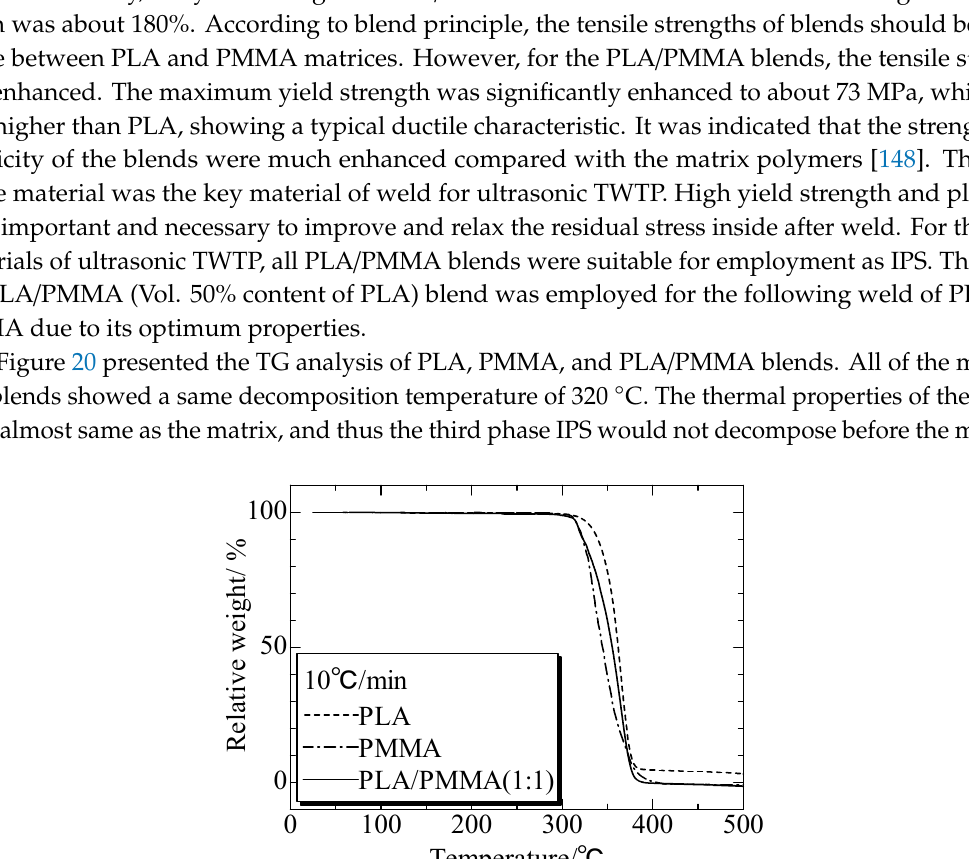
Figure 21. Welded strengths at different welding times under different welding pressures ( P ). Adapted from Reference [151]. These were similar to the welds between PC and PMMA as well as that between PLA and POM. The rupture surfaces images of welded interface were shown in Figure 22. This indicated the processes of vibrating, heat production, and welded areas enlarging. The decrease of welded strength suggested that too long a welding time or excessively strong welding pressure were harmful due to the interface overheating.